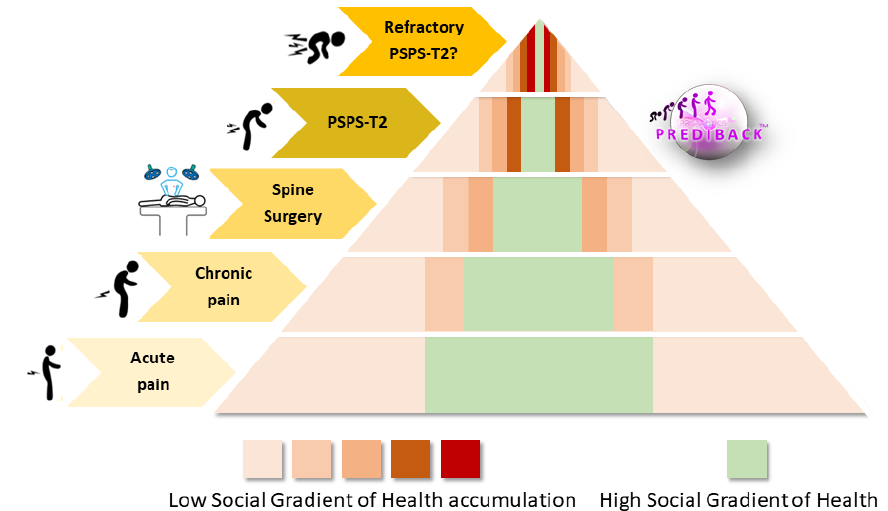
Figure 2. Illustration of the theoretical evolution of the proportion of patients with low and high Social Gradient of Health according to the different stages of the illness trajectory of Persistent Spinal Pain Syndrome type 2 (PSPS-T2) patients.